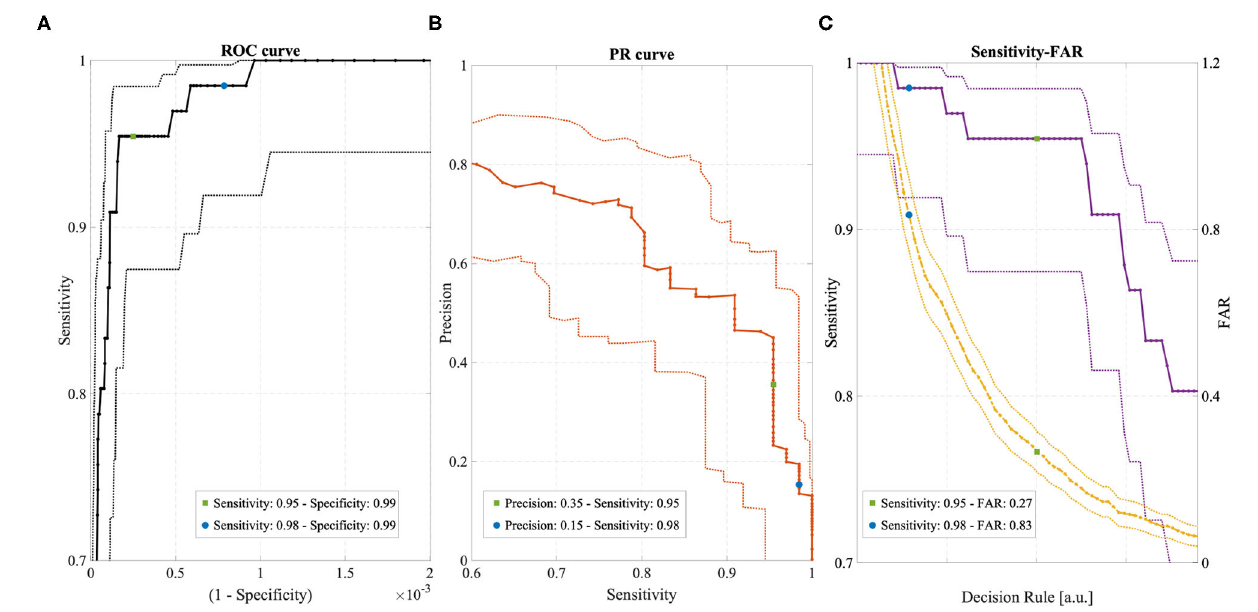
FIGURE 3 | (A) ROC curve with 95% confidence intervals (dotted lines). (B) Precision-Recall (PR) curve with 95% confidence intervals (dotted lines). (C) Sensitivity (violet) and FAR (yellow) curves with 95% confidence intervals (dotted lines). All curves were obtained by varying the operating point of the Detection Algorithm. Two operating points are highlighted in each curve, corresponding to “FDA-cleared” mode (blue circles) and “Active” mode (green